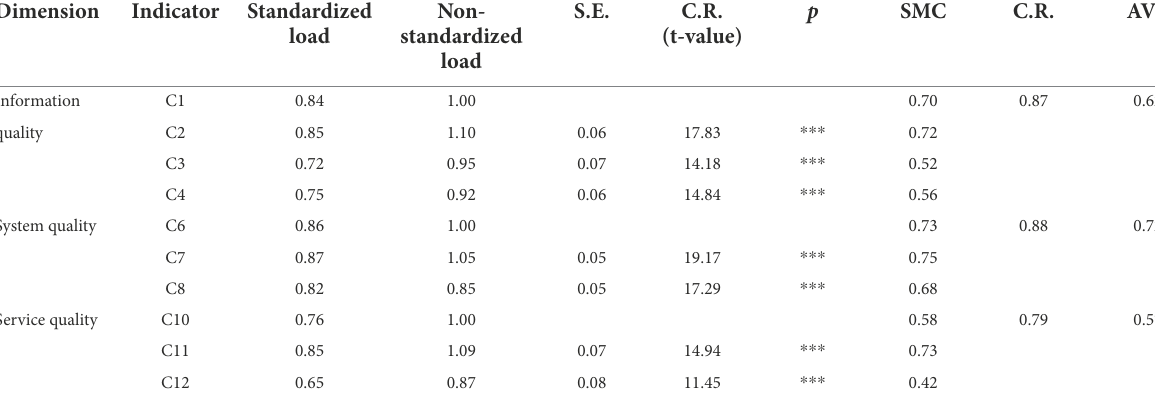
TABLE 3 Information system success model - confirmatory factor analysis.